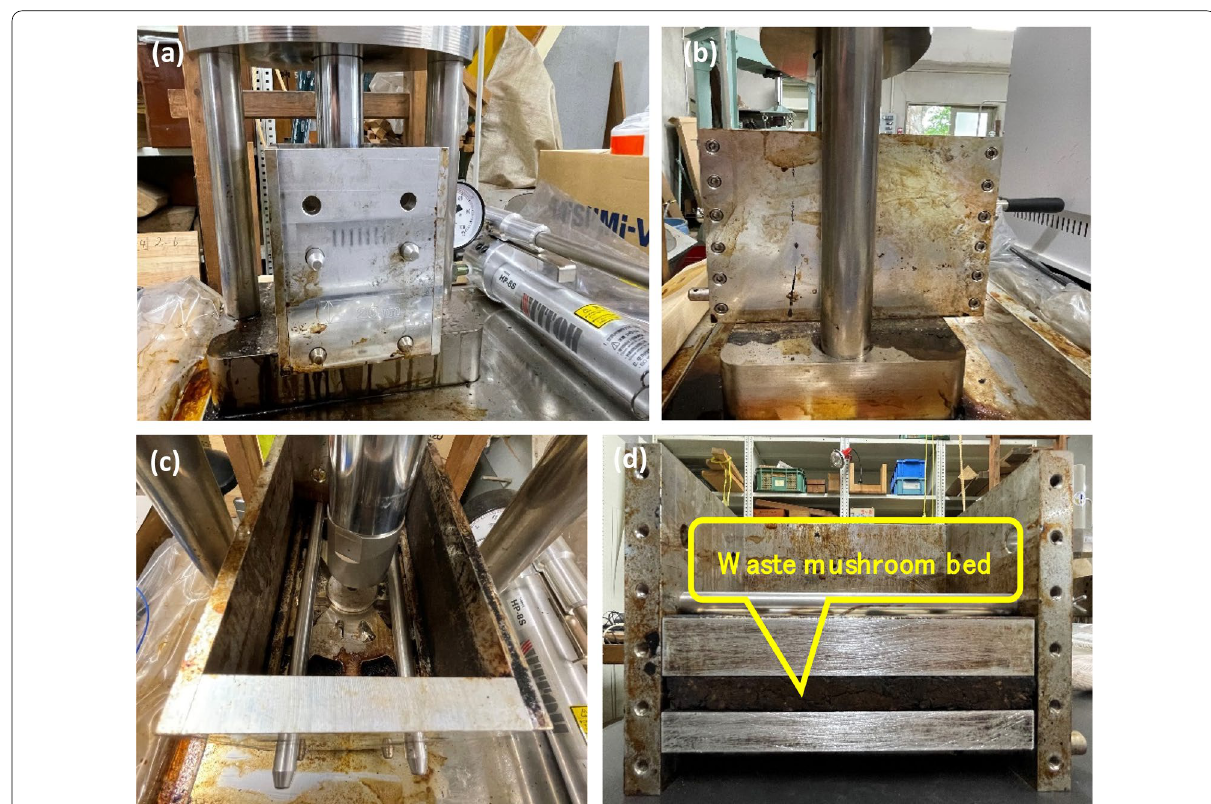
Fig. 3 Compaction equipment for the waste mushroom bed a : front view, b : side view, c : top view, d : cross section of compression formwork